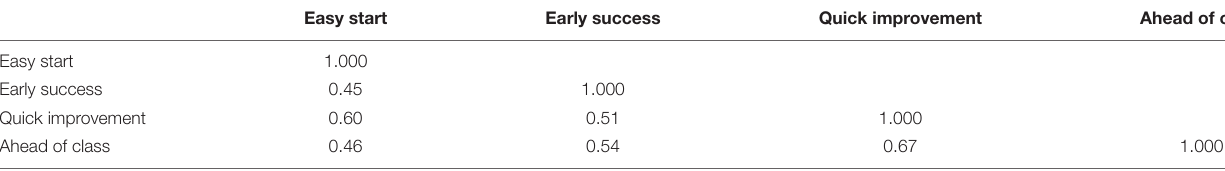
TABLE 6 | Pearson r correlation matrix “early success”.